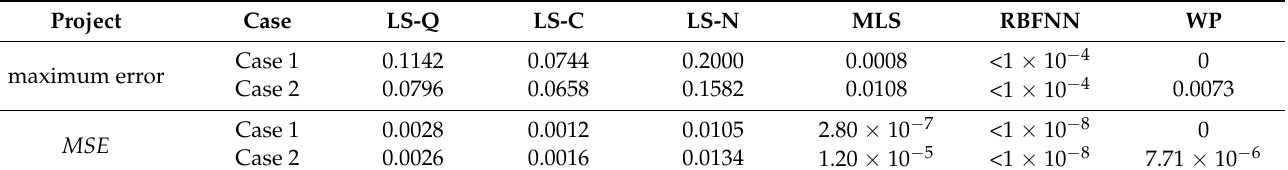
Table 2. Maximum error and MSE for TD2.